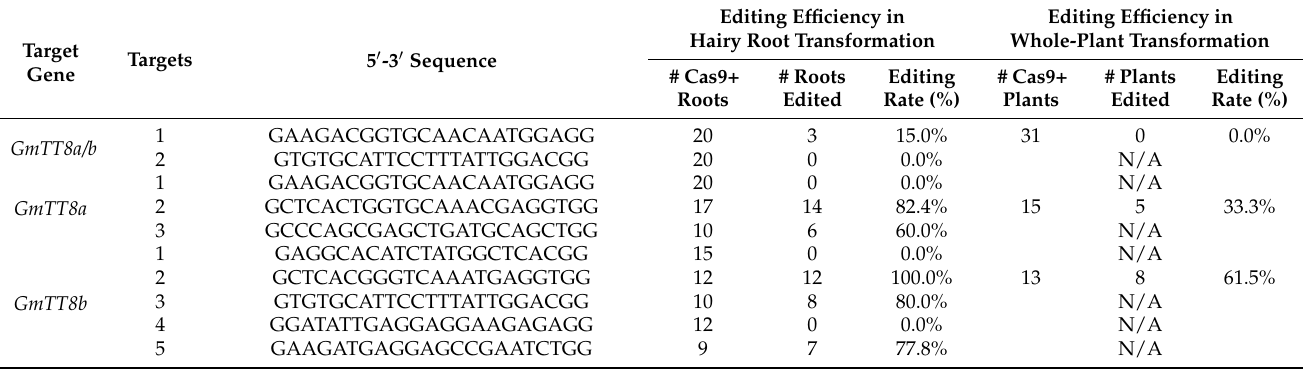
Table 3. Gene-editing efficiency of different gRNAs of GmTT8a and GmTT8b .